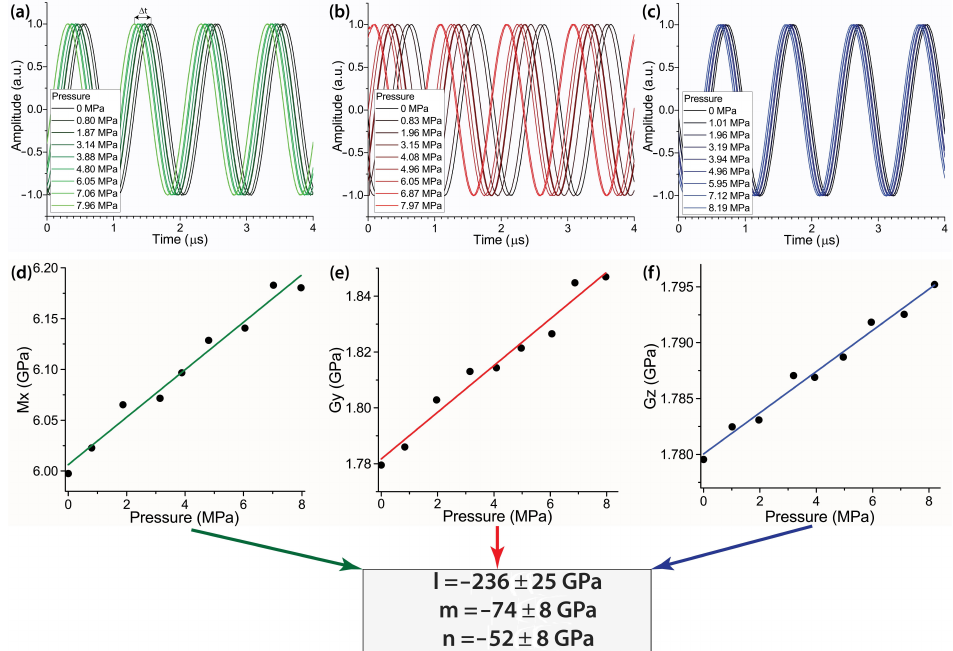
Figure 3. Illustration of the procedure aimed to determine the nonlinear elastic moduli of a composite sample on the example related to the polystyrene sample filled with 2.5% wt. graphene and 2.5% wt. C 60 nanoparticles. ( a – c ) detection of ultrasonic waves and evaluation of time delay induced by the application of static pressure onto the sample: ( a ) longitudinal waves, ( b ) shear waves perpendicular to the applied pressure and ( c ) shear waves parallel to the applied pressure. ( d – f ) calculated dependencies of effective elastic moduli: ( d ) M x , ( e ) G y and ( f ) G z on the applied pressure. The calculated Murnaghan moduli are shown in the bottom